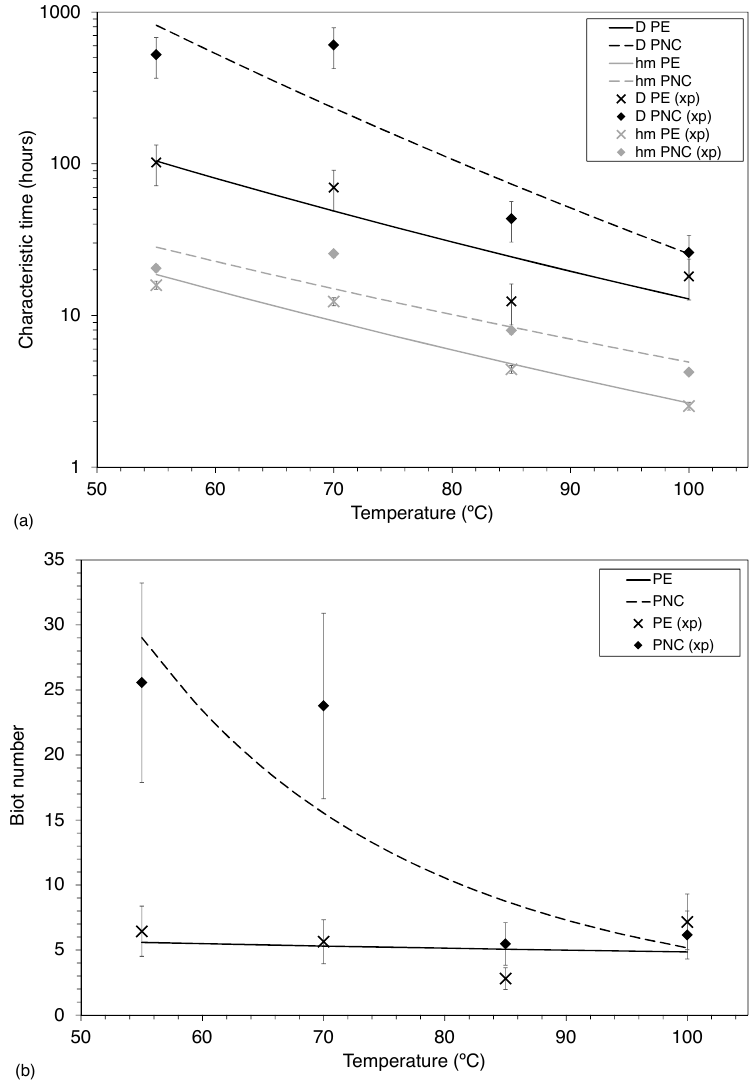
Figure 6. Effect of temperature on ( a ) characteristic times (Equations (17) and (18)) and ( b ) Biot number (Equation (19)). Experimental data are denoted by